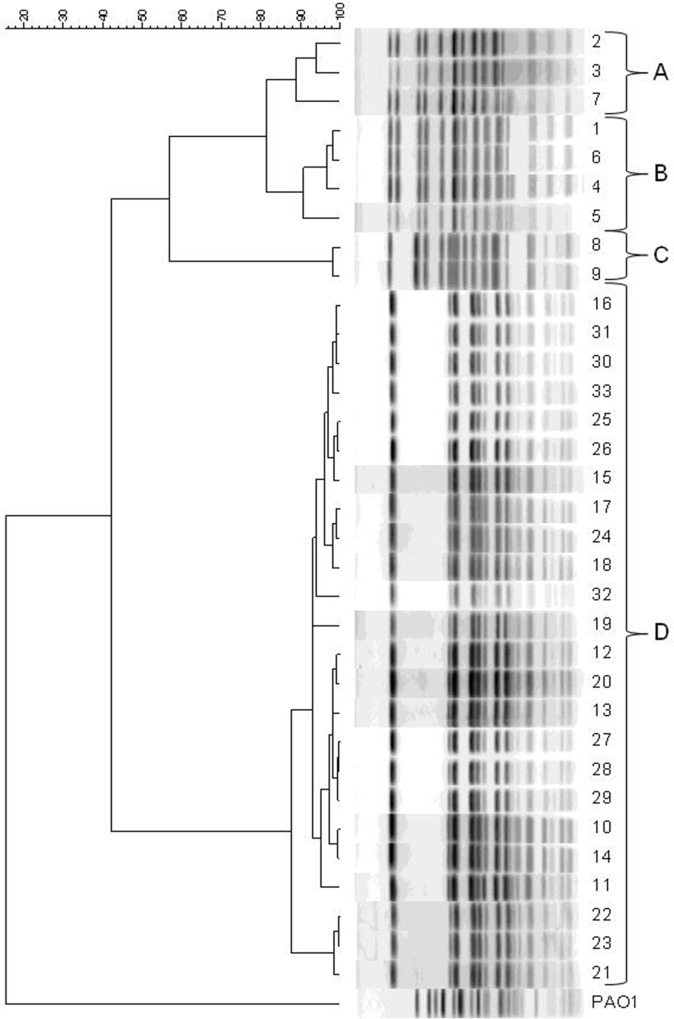
Dendrogram of PFGE-banding patterns of the 33 P. aeruginosa isolates.Clusters A and B comprise isolates from goat milk, whilist clusters C and D isolates from watering troughs.